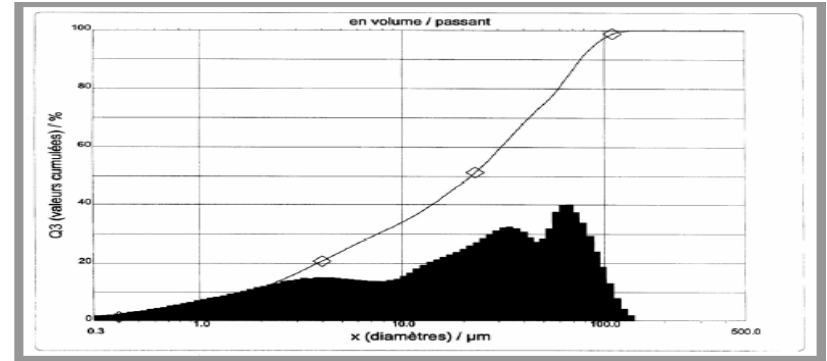
Fig. 2. Particle size distribution of the